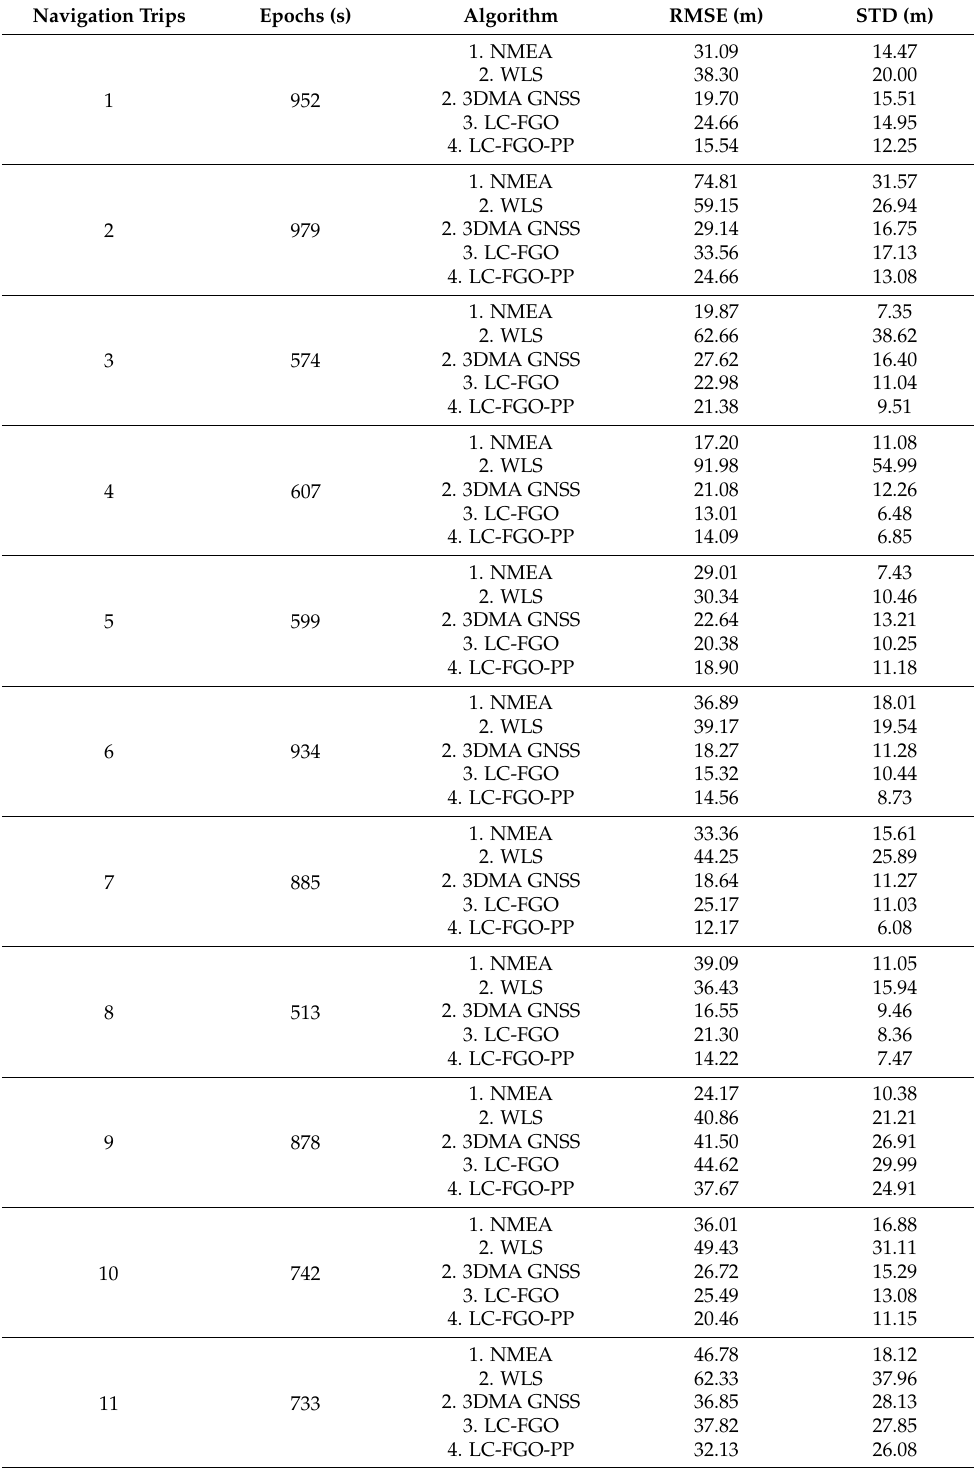
Table 1. Statistics on positioning results of all